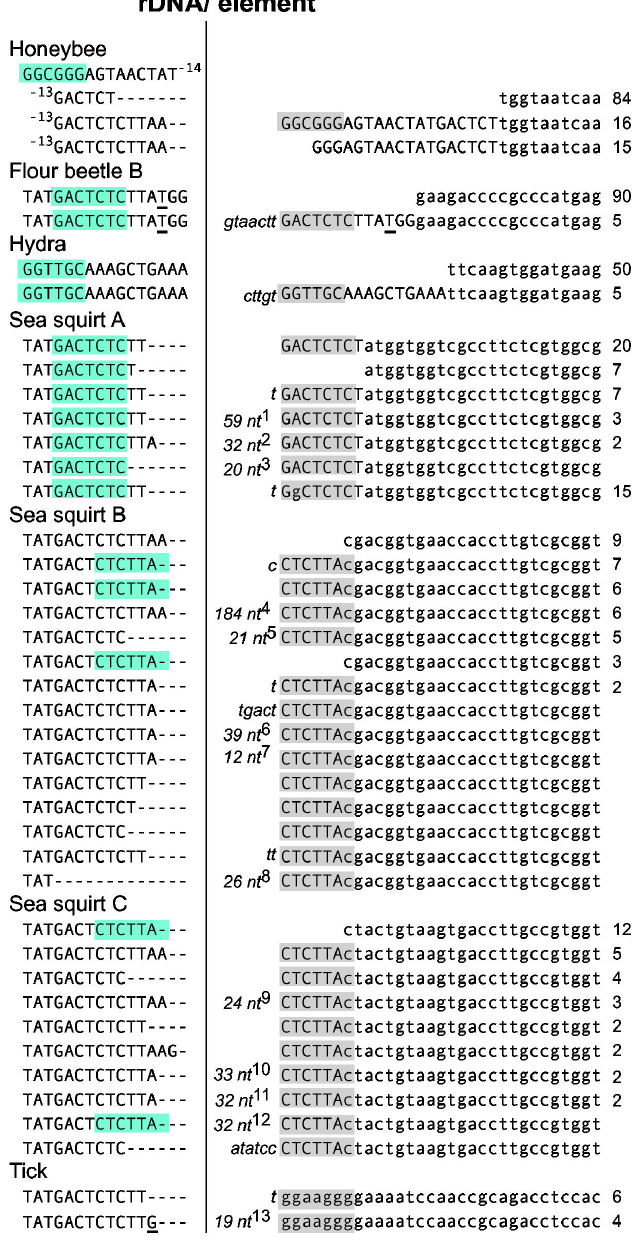
Figure 5. Variation in the 28S/R2 5' junction reflects cleavage site position. R2 sequences, 28S sequences, and non- templated sequences are as described in Figure 1. Single nucleotides in the flour beetle and tick 28S genes that differ from the consensus arthropod 28S gene sequence are underlined. All sequences are derived from the trace reads of genomic sequencing projects. The number of trace reads containing the same junction sequence is indicated to the far right. Nucleotides that could form the 5' end of the predicted P1 stem of the ribozyme (Supporting Information, Figure S2) are boxed in blue if from the 28S gene or in gray if from R2. Two regions can potentially anneal because of 28S duplications associated with some junctions. Sequences not presented in the